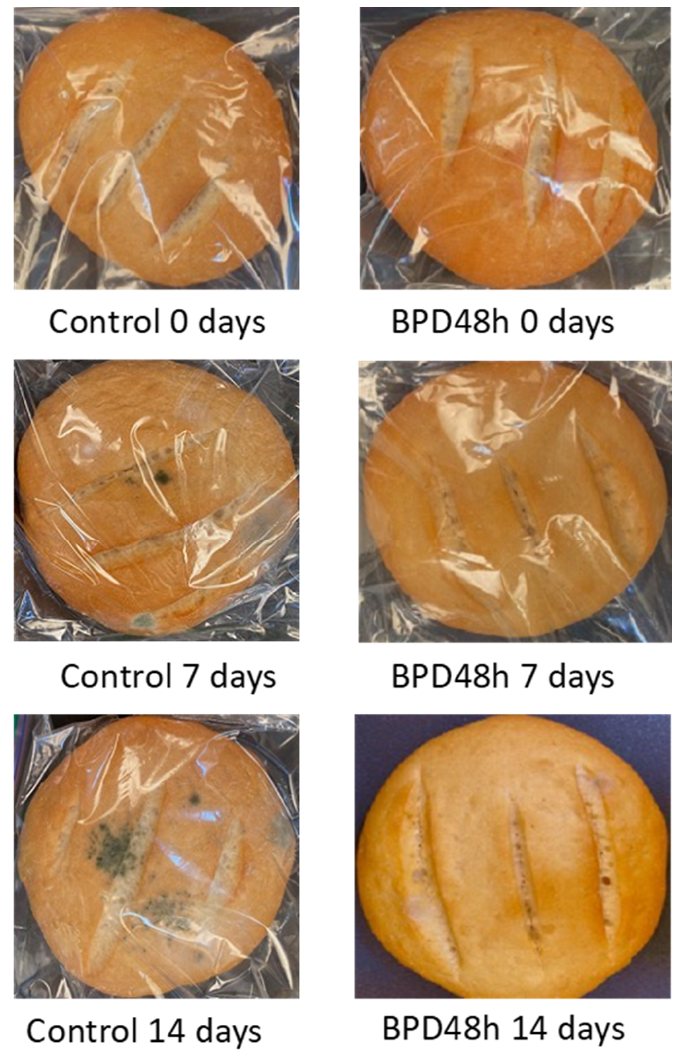
Figure 6. Fungal growth on the control loaves of bread and bread supplemented with fermented poolish-type sourdough with Lactiplantibacillus plantarum NRRL B-4496 for 48 h (BPD48h) during storage at 25 °C.